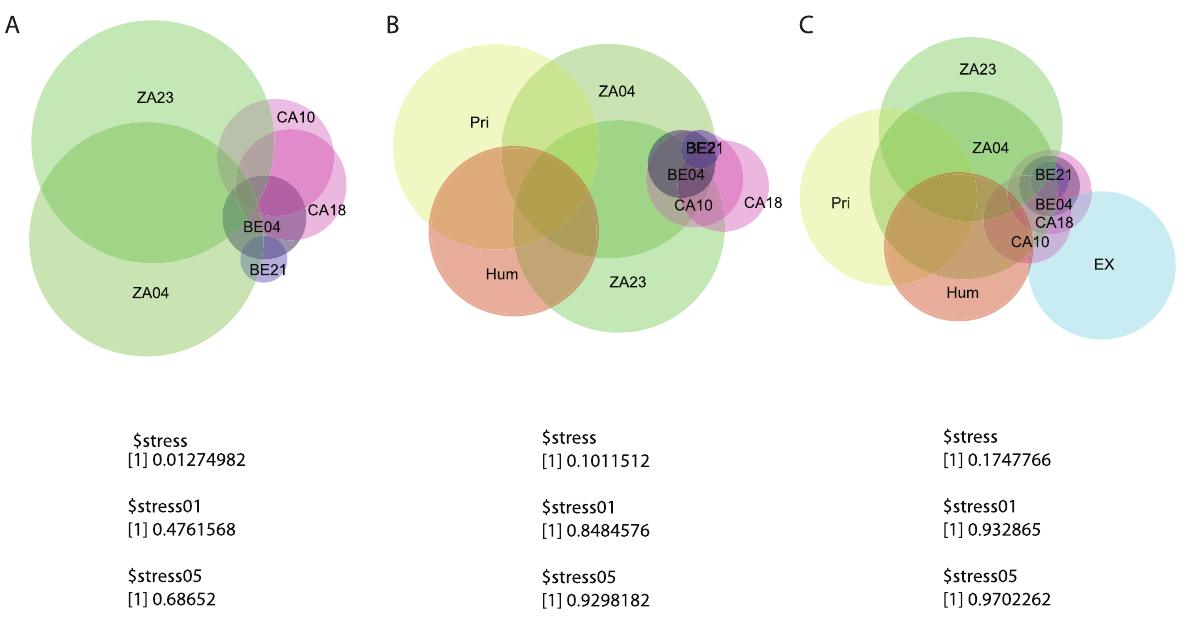
Figure 2. Venn-Euler diagram of OTUs at 97% pairwise identity representing 1,045 OTUs. The sizes of the circles and intersections are proportional to the number of OTUs listed and shared by each sample. Stress value for A is 0.01274982, and it increased in B and C as more samples are added. All the stress values are lower than the predicted value at 0.01 and 0.05, suggesting that the grouping is non-random.